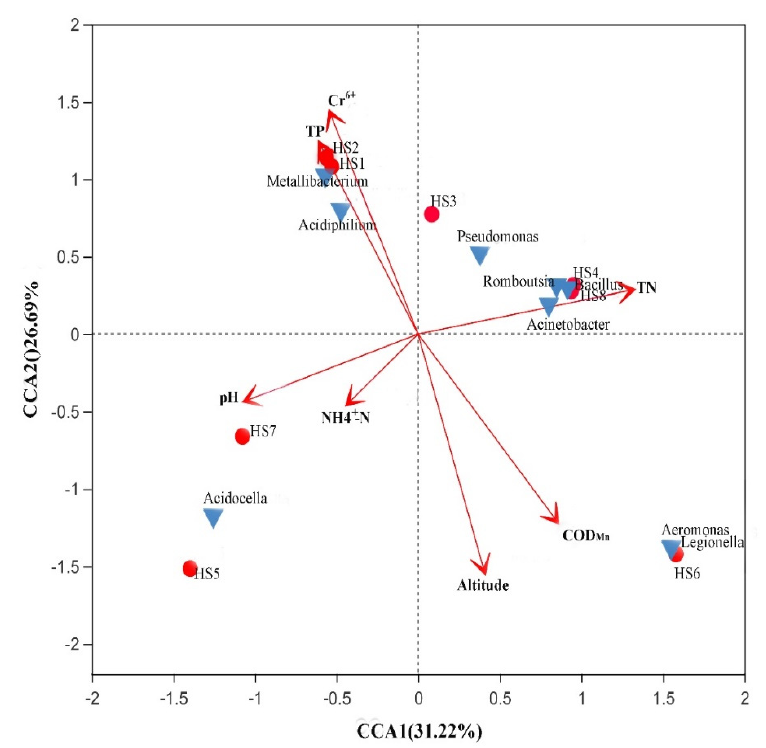
Figure 4. Canonical correspondence analysis (CCA) graph for the microorganism community and environmental factors. Red-filled circles indicate the water samples at the HS1–HS8 sites in the Huangshui River. Blue triangles indicate the top 8 genera among the eight sampling sites.